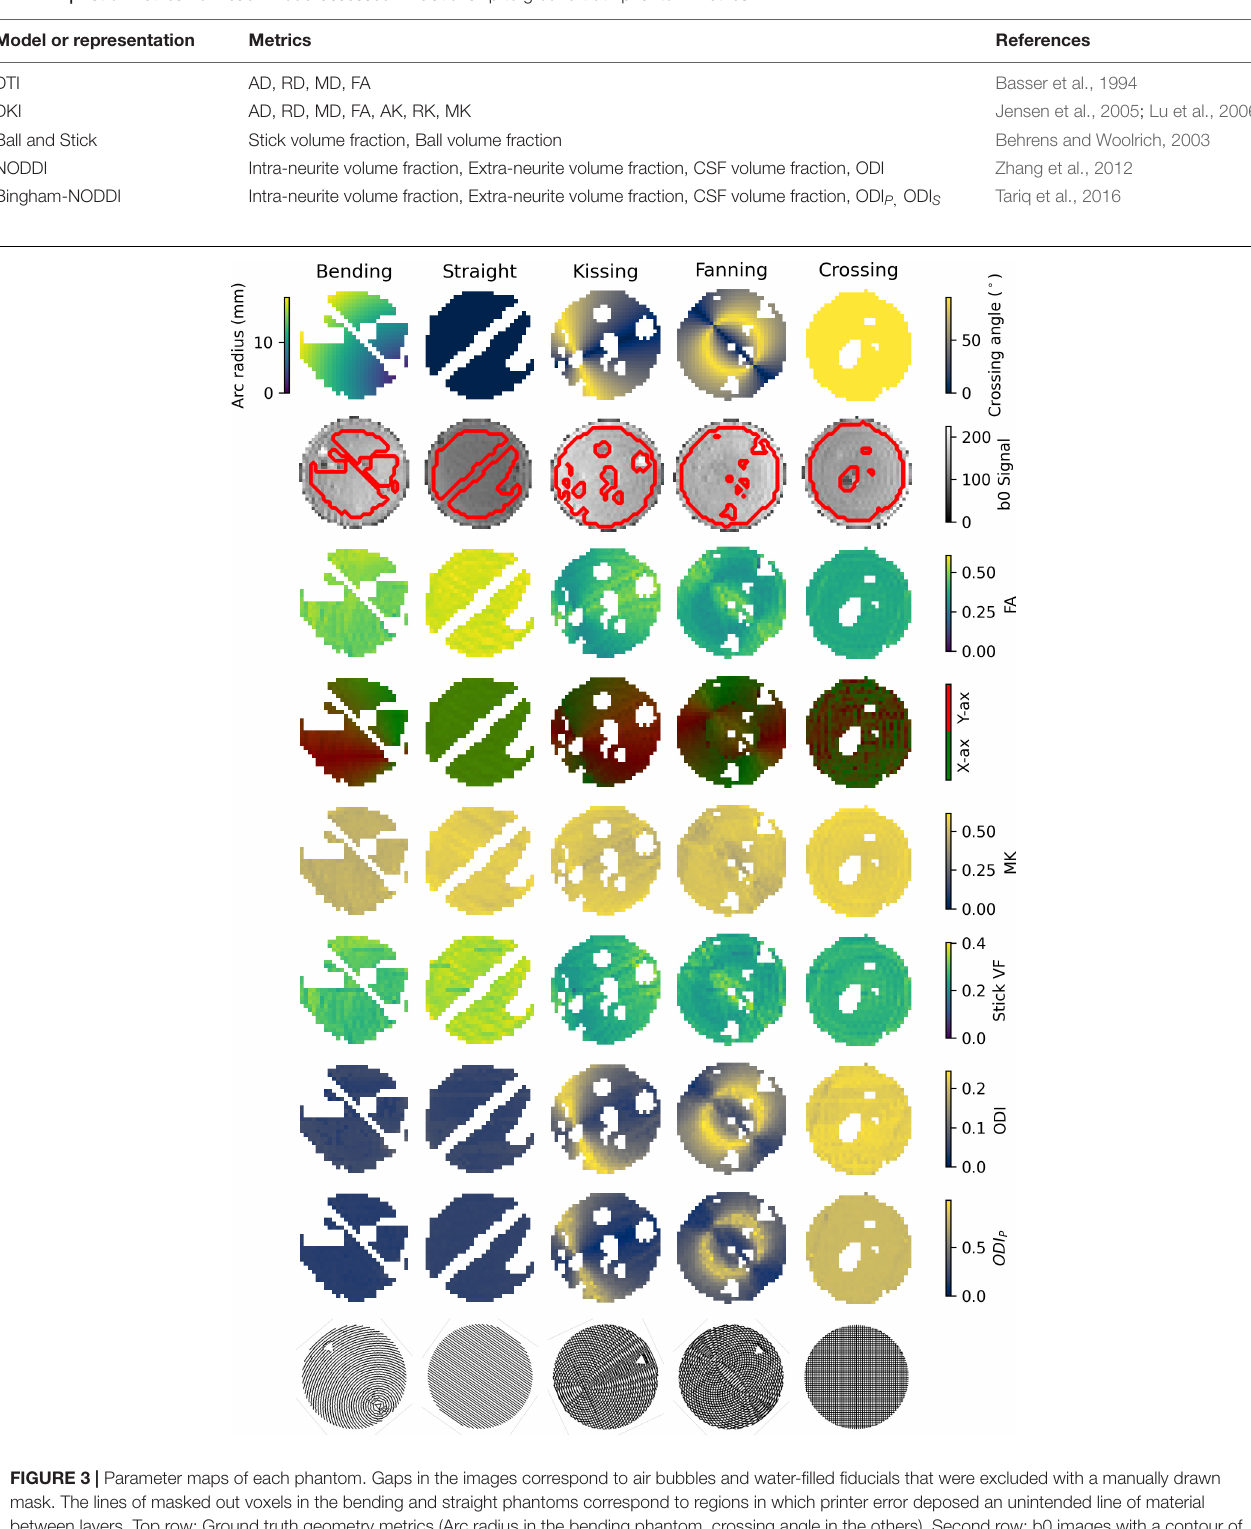
Frontiers in Neuroscience |